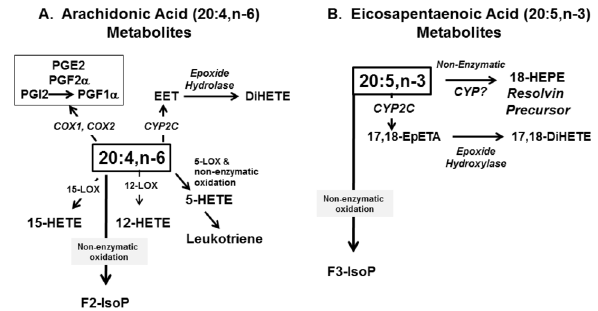
Figure 14. Pathways for the formation of oxidized lipids from arachidonic acid (20:4,n-6) [Panel A] and eicosapentaenoic acid (20:5,n-3)[Panel B]. See text for explanation.